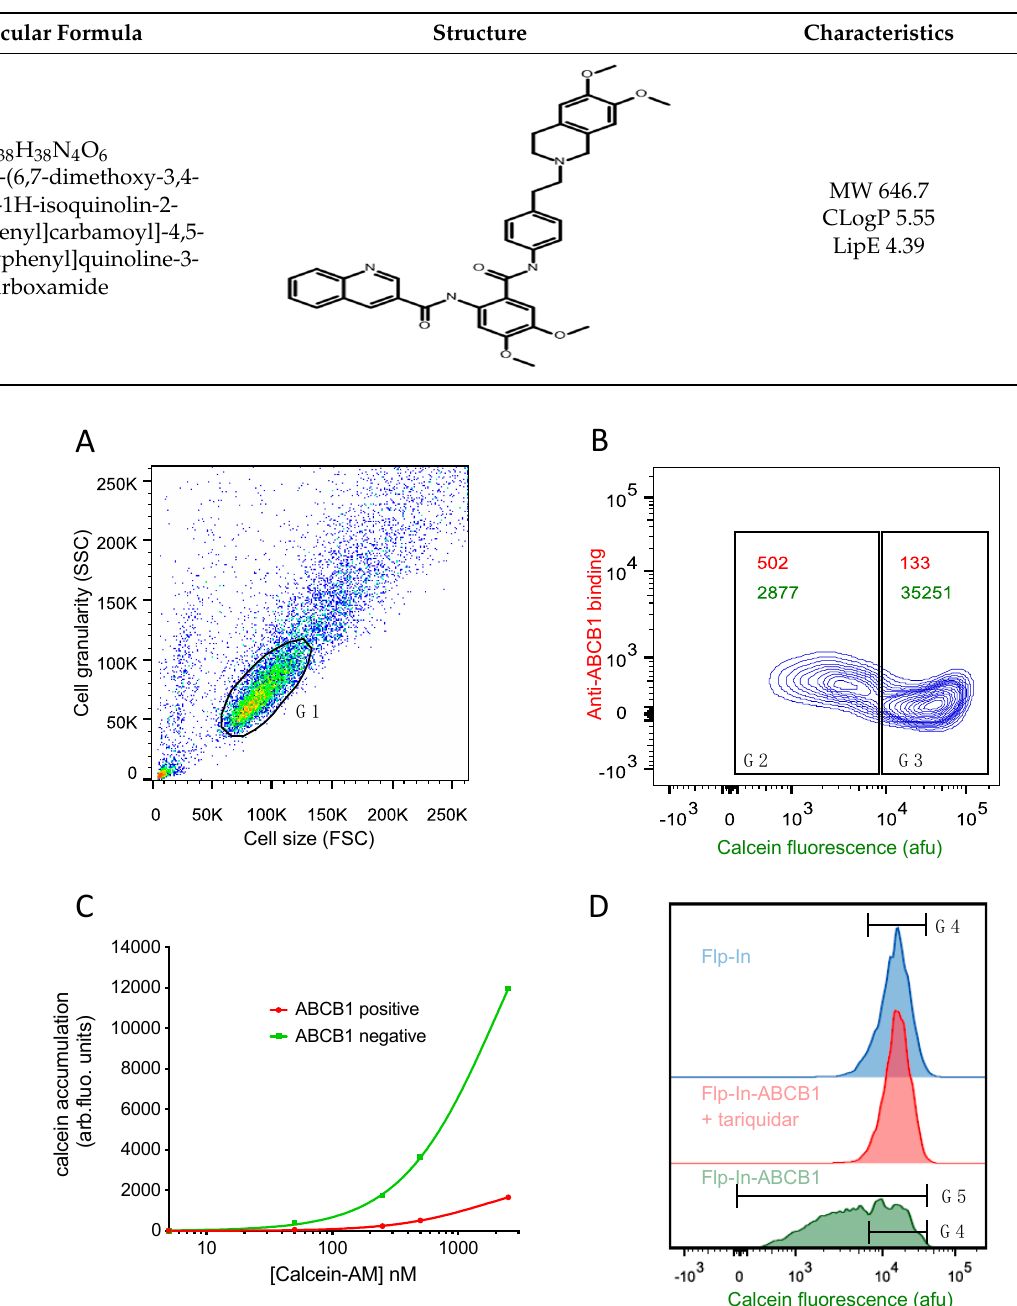
Figure 2. ABCB1 in the Flp-In-ABCB1 cells effluxes calcein-AM and is fully inhibitable by tariquidar. Live cells were labelled with a non-inhibitory antibody (4E3) that recognizes an extracellular epitope of ABCB1 and challenged with 500 nM calcein-AM. ( A ) Dotplot showing the autogating of cells (solid black line; G1) for uniform size and granularity. ( B ) Contour plot of the G1 population showing that ABCB1 expression (y-axis) reduces accumulation of calcein in the cell (x-axis). Gate G2 delineates the ABCB1-positive population with the anti-ABCB1 median = 502 arbitrary fluorescence units (afu) in red and a calcein accumulation median = 2877 afu in green, while gate G3 delineates the internal ABCB1-negative control with anti-ABCB1 median = 133 afu in red and calcein median = 35,251 afu in green. ( C ) Titration of calcein-AM showing that 250 nM is sufficient to begin to induce calcein accumulation in the ABCB1-positive cells (red curve) while retaining a significant difference in the accumulation in ABCB1-negative cells. ( D ) Tariquidar (1 nM) fully inhibits ABCB1 to allow calcein (250 nM) accumulation in all cells. Gate G4 centred on the peak of calcein content of the non- expressing Flp-In cells (representing about one third of the population of Flp-In-ABCB1 cells) di- vided by the median calcein accumulation in the whole population (Gate G5) provides a measure of ABCB1 activity.